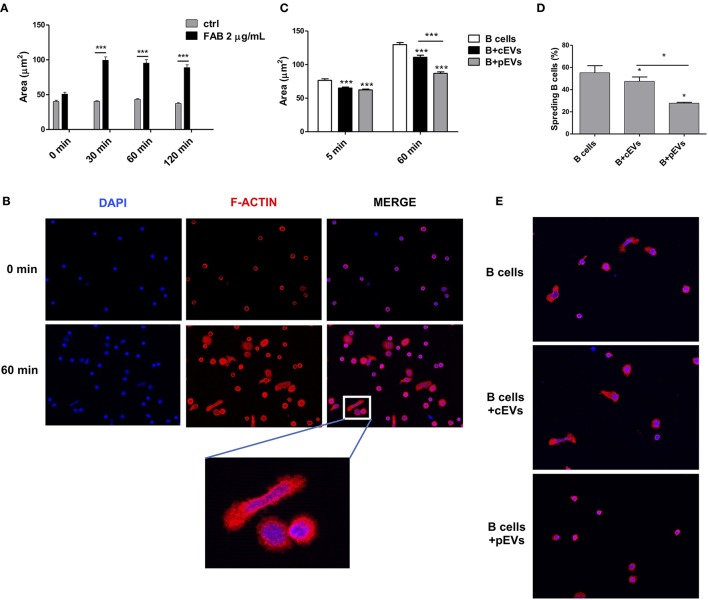
B cell spreading inhibition mediated by MSC-EVs. (A) Cell area of B cells plated on coverslips coated or not with F(ab′) 2 anti-human IgM/IgA/IgG (n = 42–204). (B) Double-stained B cells with DAPI (blue) and rhodamine phalloidin (F-actin, red) before and after the induction of cell spreading (60 min). (C) Cell area of B cells pre-treated with cEVs or pEVs and then plated on coated coverslips (n = 212–398). (D) Percentage of spread B cells treated with cEVs or pEVs after 60 min of incubation on coated coverslips. (E) Double-stained B cells with DAPI (blue) and rhodamine phalloidin (F-actin, red) after 60 min of incubation on coated coverslips. The images are representative for three independent experiments with similar results (Original magnification 400x). Error bars represent mean ± SEM of three independent experiments. t-test *p < 0.05, ***p < 0.001.